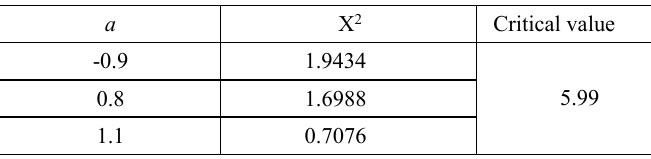
Table 2. Results of serial test.